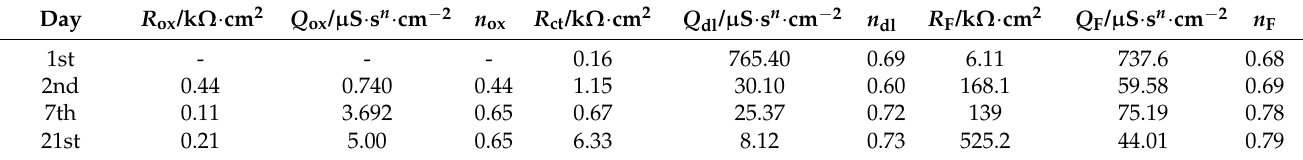
Figure 9. EIS spectra for RG7 bronze for continuous immersion in artificial urban rain at pH 6.5. ( a ) Bode phase angle; ( b ) Bode impedance. Table 6. EIS data for CuSn12 for continuous immersion in simulated urban rain at pH 6.5.